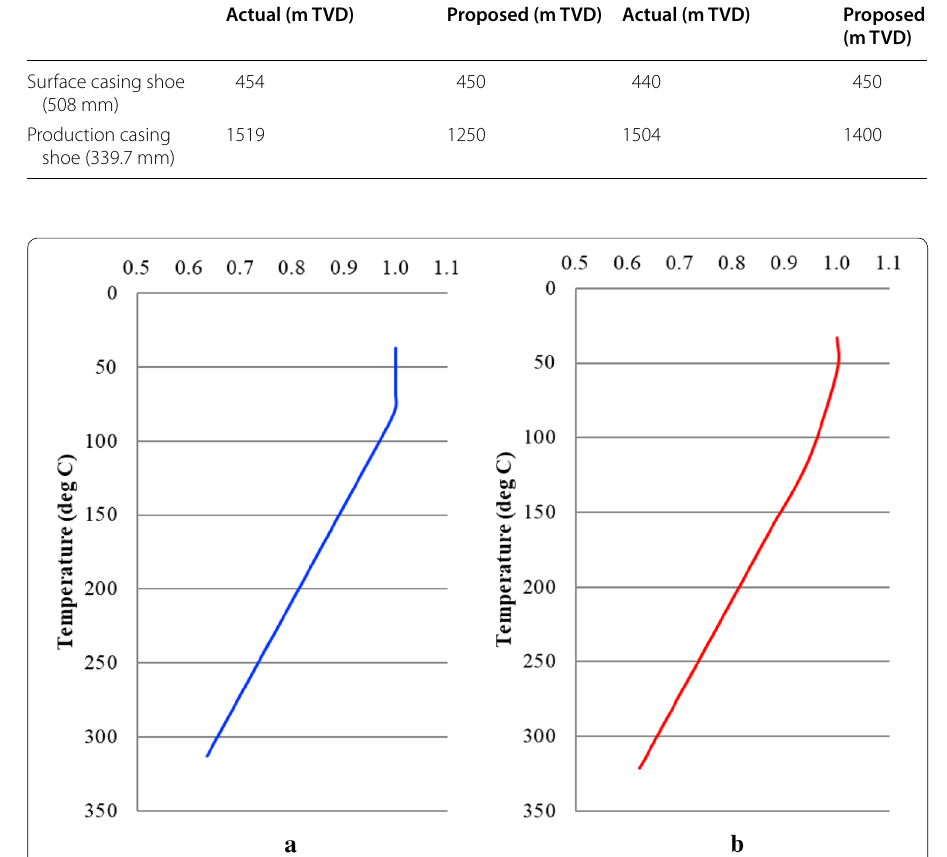
Fig. 7 Yield strength correction factor due to temperature for a well HCE9B and b well